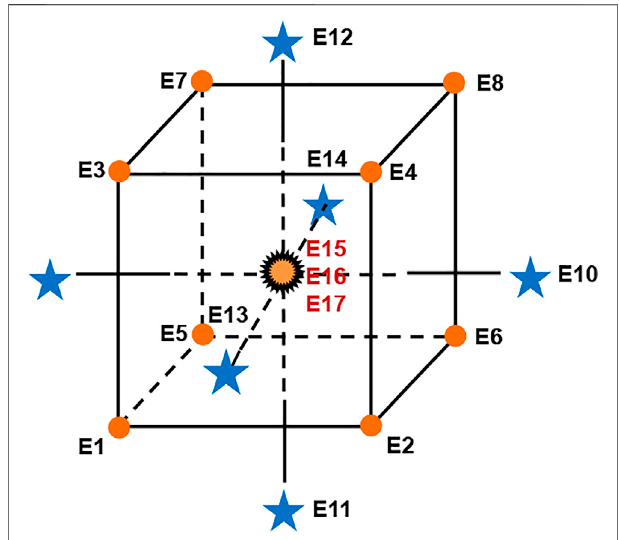
FIGURE 3 | Schematic illustration of CCD (dot in the middle of cube represents three replicates of the center point).